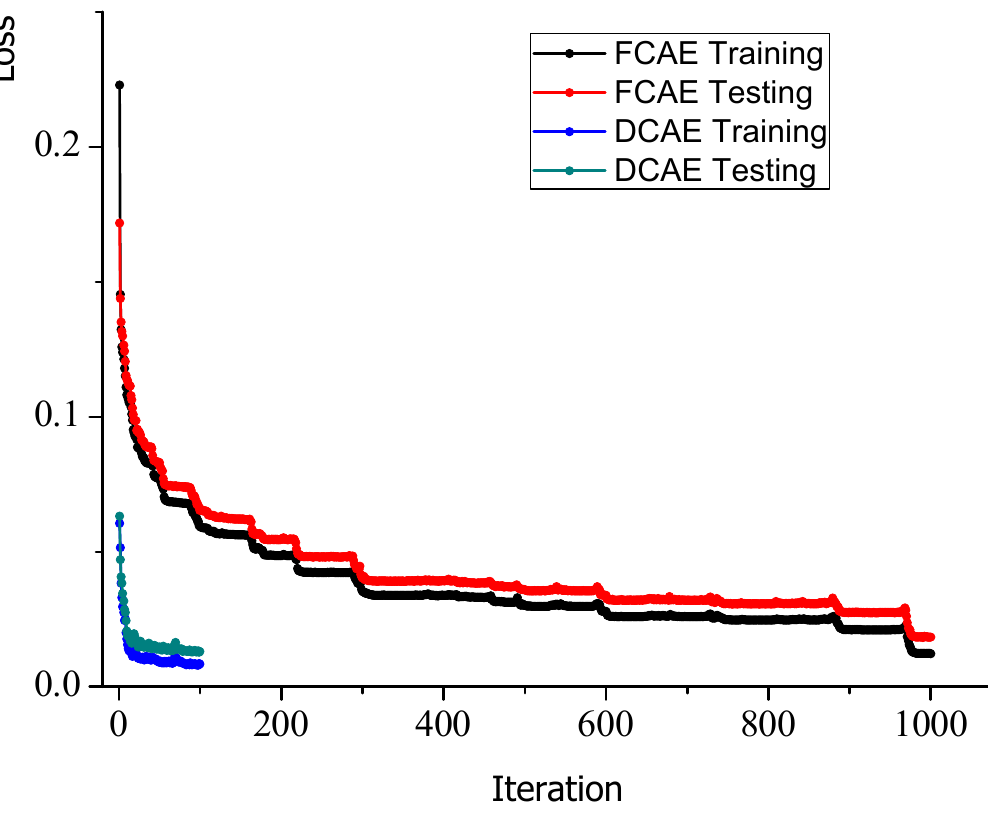
Figure 4. Loss function of the FCAE and DCAE on the dataset.